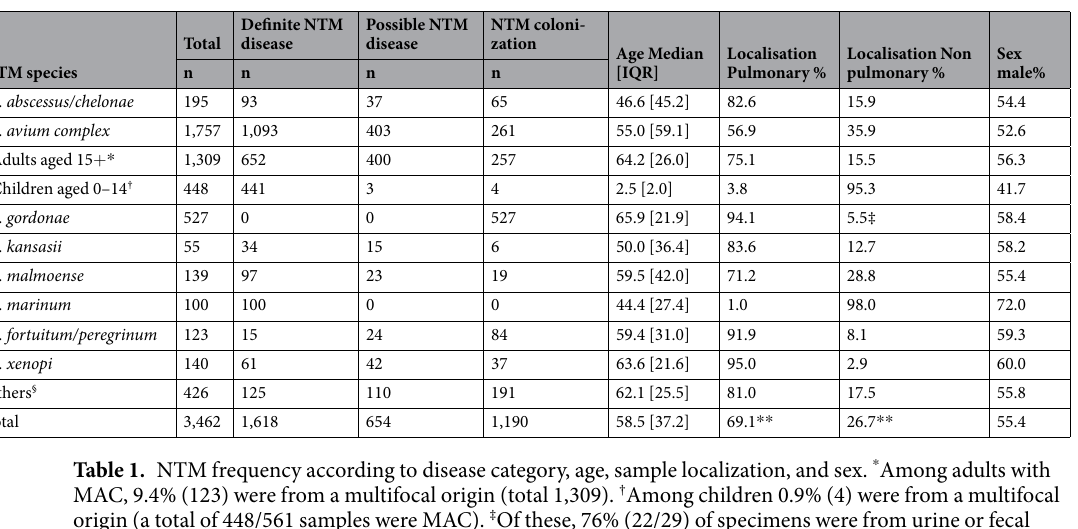
shown in Table 2. The annual number of positive cultures in the population did not increase or decrease during the study period (p = 0.836, data not shown). NTM incidence rates.